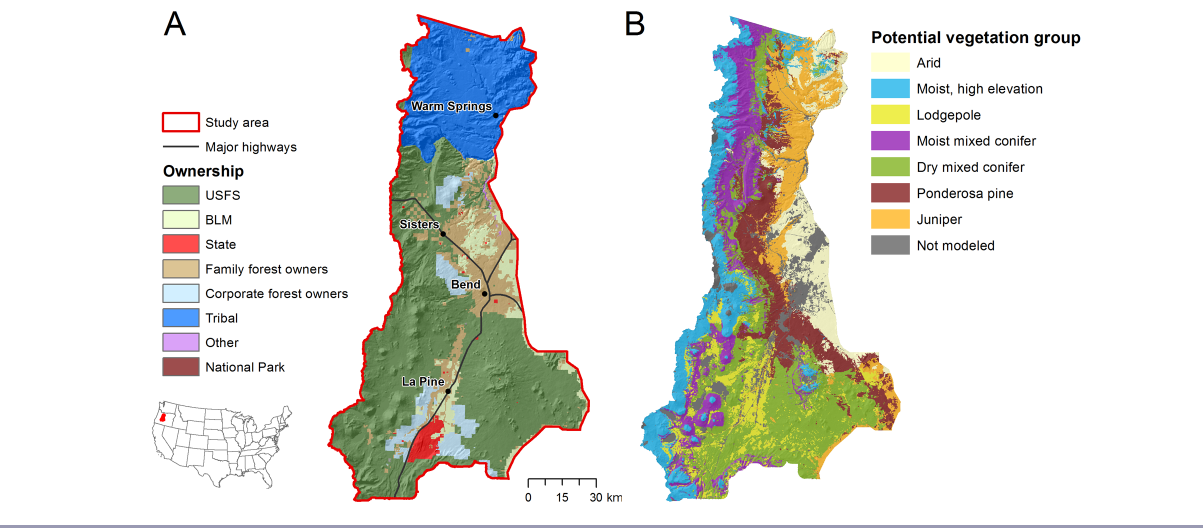
Fig. 1 . Map of the study area showing (A) ownerships, towns, and major highways and (B) potential vegetation groups derived from Halofsky et al. (2014). BLM = Bureau of Land Management, USFS = U.S. Forest